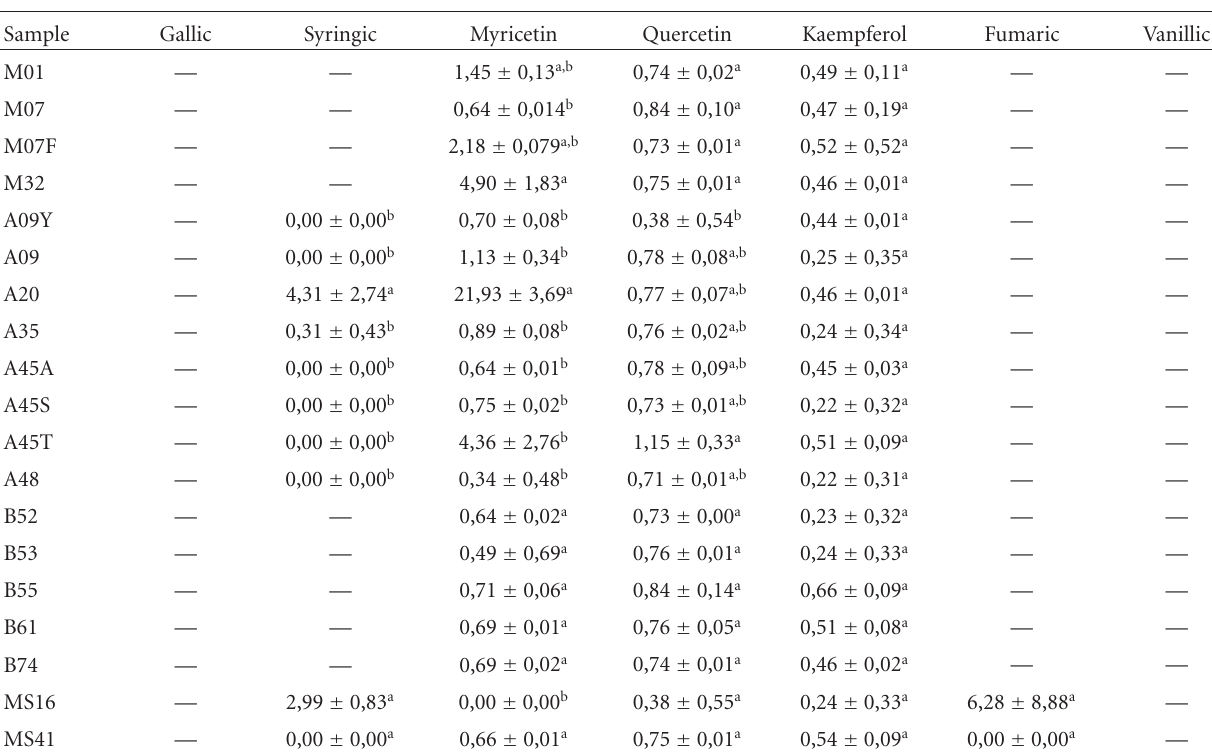
Table 3: Phenolic content of fresh nettle